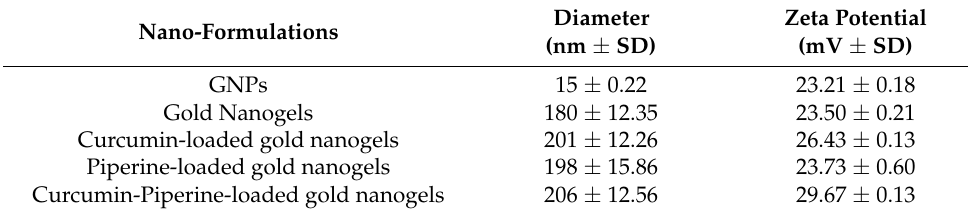
Table 1. The average hydrodynamic diameter and zeta ( ζ ) potential values of various nano-